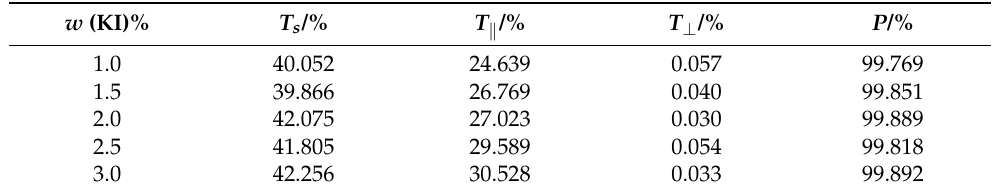
Table 2. The calculated values of single, parallel, perpendicular transmittance and degree of polariza- tion of PVA polarizing films with the concentrations of KI being set to 1.0%, 1.5%, 2.0%, 2.5% and 3.0%, respectively, when the draw ratio was